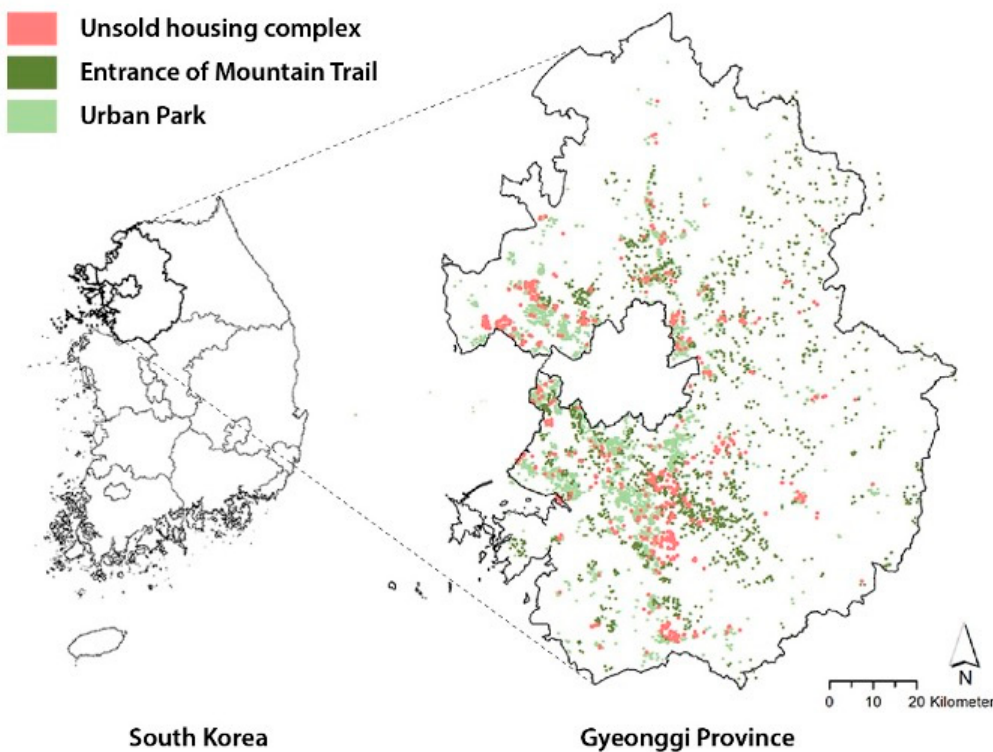
Figure 2. The locations of urban parks and entrances of mountain trails surrounding unsold housing complexes in Gyeonggi Province, South Korea, from 2012 to 2018.